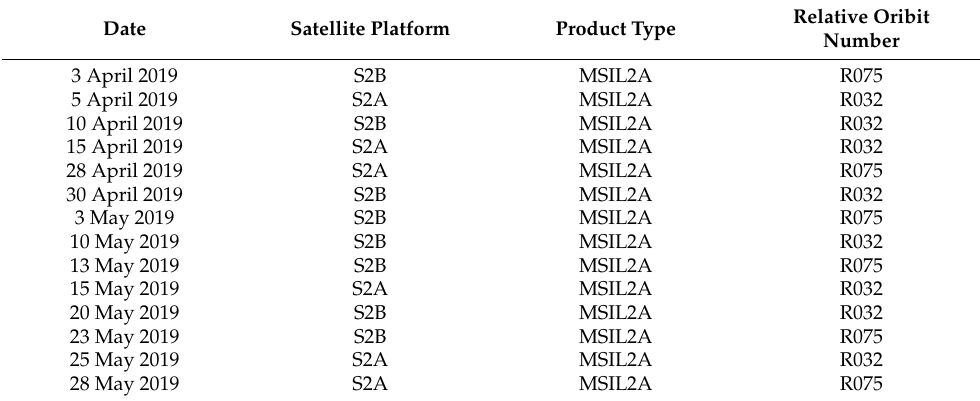
Table 1. Some specific information on the Sentinel-2 optical data.